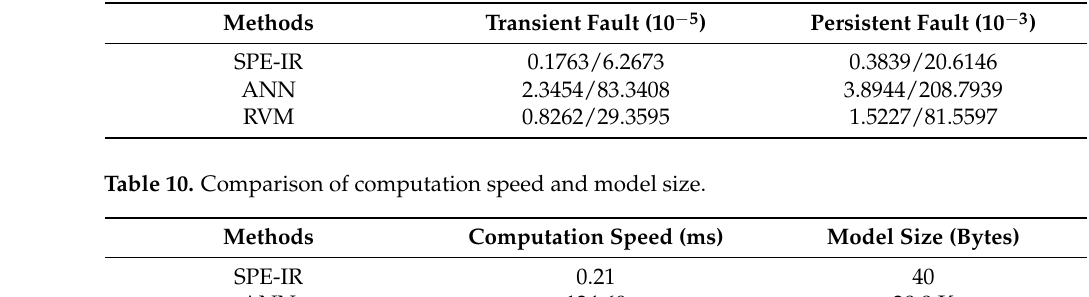
Figure 14. Data recovery of RVM: ( a ) Transient fault; ( b ) Persistent fault.